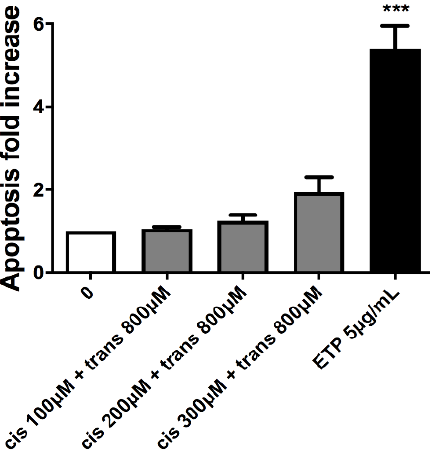
Figure 5. Apoptosis fold increase in TK6 cells after 26 h co-treatment with (±)cis- 4,4′ -DMAR and (±)trans- 4,4′ -DMAR or the positive control ETP at the indicated concentrations compared to the concurrent negative control [0 µM]. Each bar represents the mean ± SEM of three independent experiments. Data were analysed using one-way repeated measures ANOVA followed by Bonfer- roni as post-test. *** p < 0.001 vs . [0 µM].